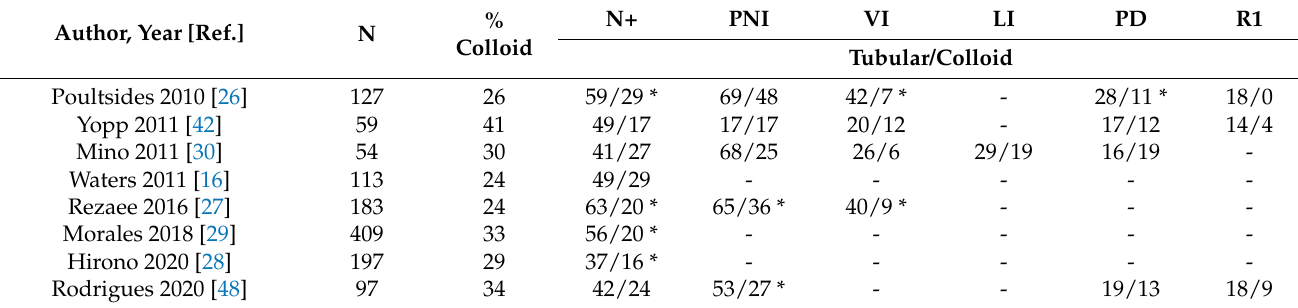
Table 2. Pathological features of colloid versus tubular type